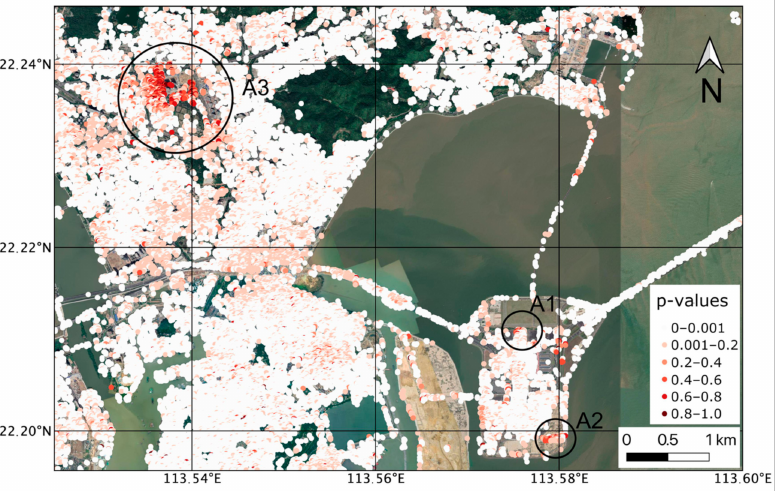
Figure 15. The p -values from the ADF test after removing the linear and seasonal components.